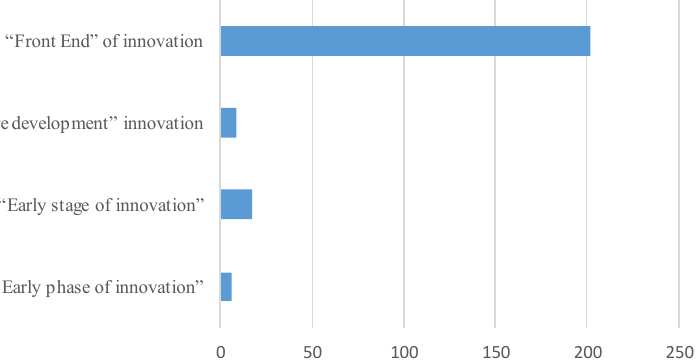
Fig. 1. Results found concerning the possible nomenclatures to be used in the